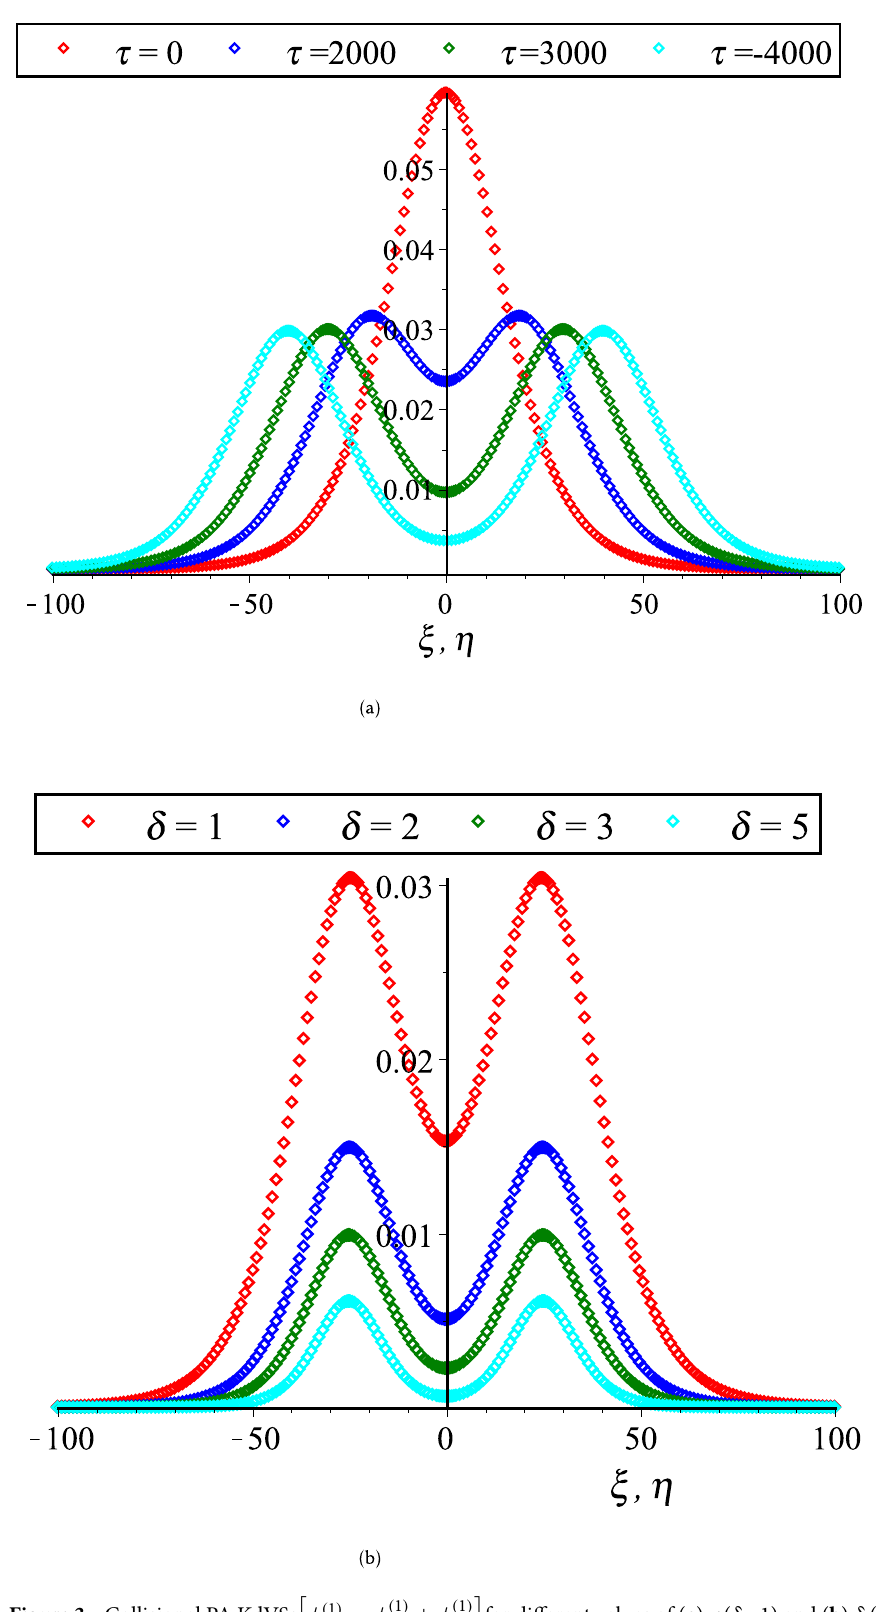
Figure 3. Collisional PA KdVSs remaining dimensionless parameters are chosen as N hc = 0.08, N ec = 0.5 and σ = 0.5 with U 0 = 0.01, r = 0.1 and q =